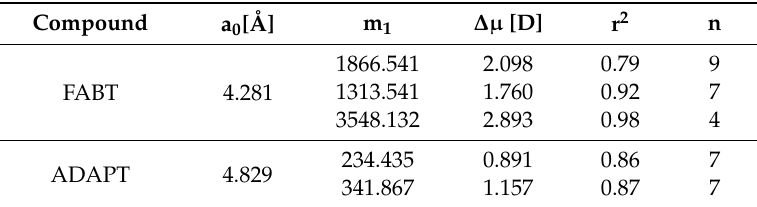
Table 1. Onsager cavity radius a 0 , slope m, change in dipole moment Δµ, coefficient of determination r 2 and number of data for compound FABT and ADAPT.